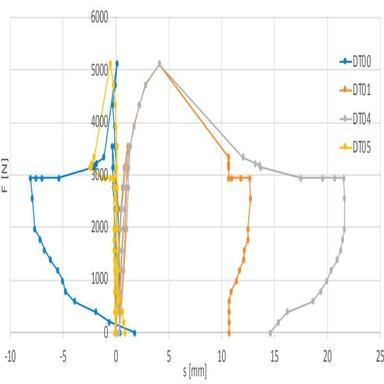
Reinforced vault: load-displacement diagrams.